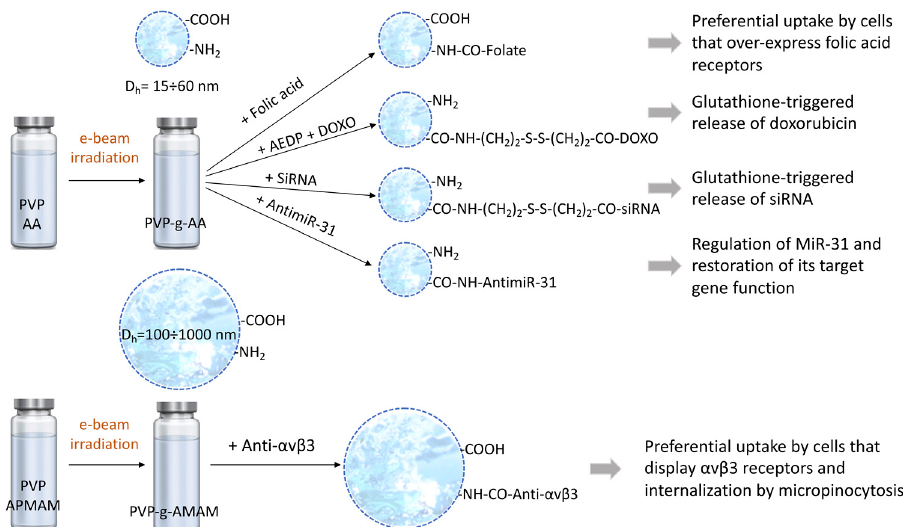
Figure 8. PVP-g-AA and PVP-g-APMAM nanogels produced by e-beam irradiation. The range of average hydrodynamic sizes—obtained by varying polymer concentration, nature of the grafted monomer, and irradiation conditions—are reported. Decoration of the various nanogels with folic acid or Anti-avb3 as targeting ligands, and with potentially therapeutic biomolecules, such as SiRNA, AntimiR-31, or with the cytotoxic doxorubicin were performed. Based on [83–88].